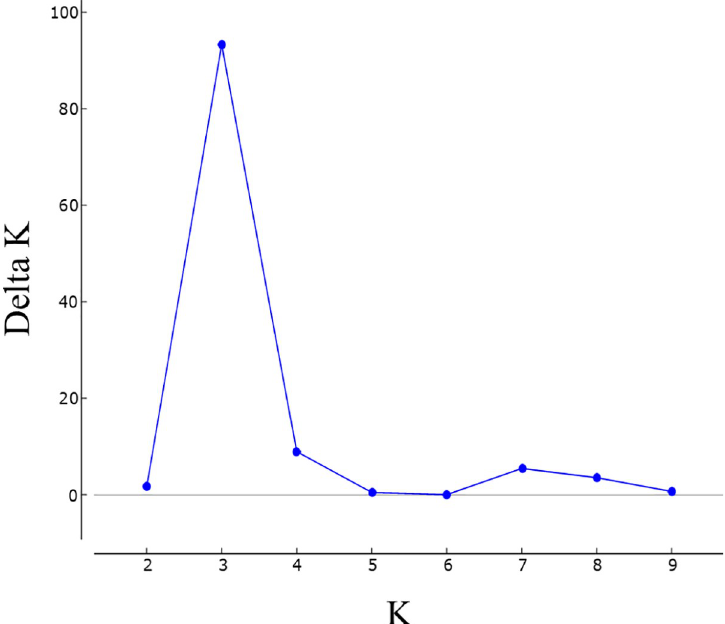
Fig 1. STRUCTURE Harvester results. The most probable number of genetic clusters (K) within the full data set of 410 individuals based on the method described by Evanno et al. (2005) [51]. Delta K graph determined the maximum value at K =